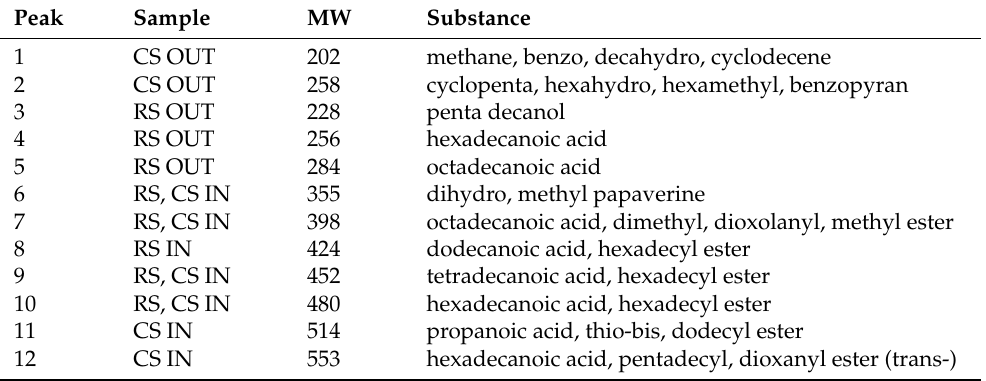
Table 3. Substances identified with GC-MS for RS and CS before (IN) and after (OUT) AD.